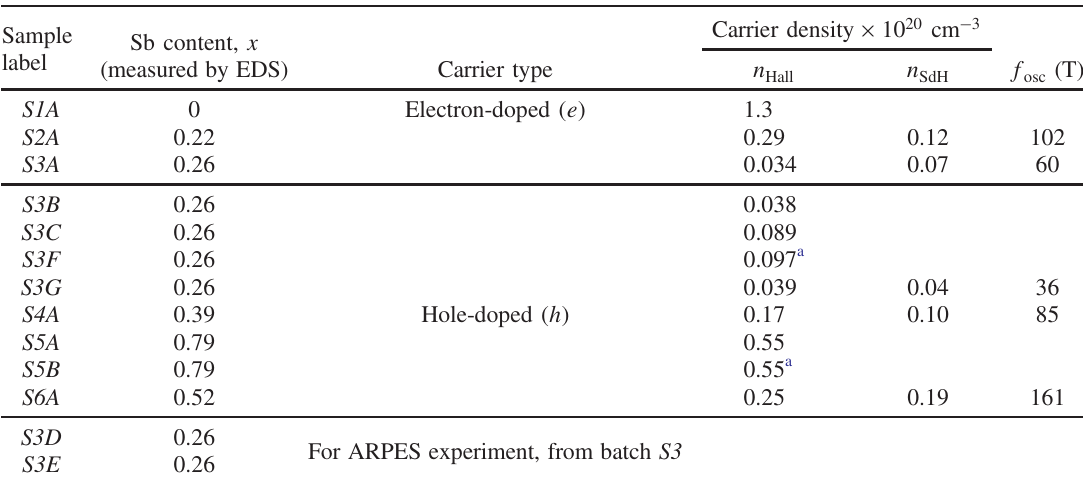
TABLE I. Information of the Mn ð Bi 1 − x Sb x Þ 2 Te 4 samples used in this study, including Sb content x , carrier type, SdH oscillation frequency f , and carrier densities estimated from Hall coefficient and f osc density is extracted from the linear background of ρ yx in FM phase at 2 or 0.7 K. For the lightly hole-doped samples ( S3B and S3C ) which exhibit strong nonlinear field dependence in ρ yx due to the coexistence of electron and hole pockets, the Hall carrier densities given in the table represent the difference between the hole and electron density, n − n ρ h e , estimated from the slope of yx in the high field limit (approximately 40 T), where (see the